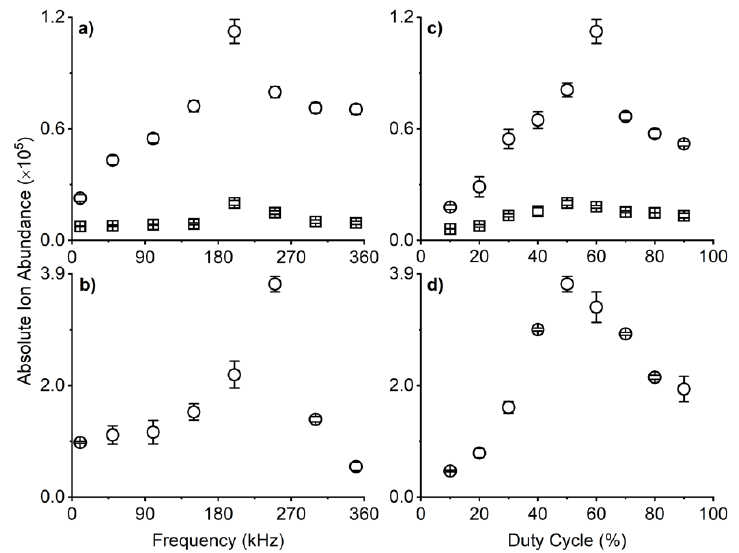
Figure 4. Absolute ion abundance of myoglobin (5 µM) ( a , c ) and angiotensin II (1 µM) ( b , d ) as a function of frequency ( a , b ) and duty cycle ( c , d ) in pulsed nESI-MS. The spectra were collected at a frequency ranging from 10 to 350 kHz (duty cycle of 50%) and a duty cycle ranging from 10 to 90% (frequency of 250 and 200 kHz for angiotensin II and myoglobin, respectively).